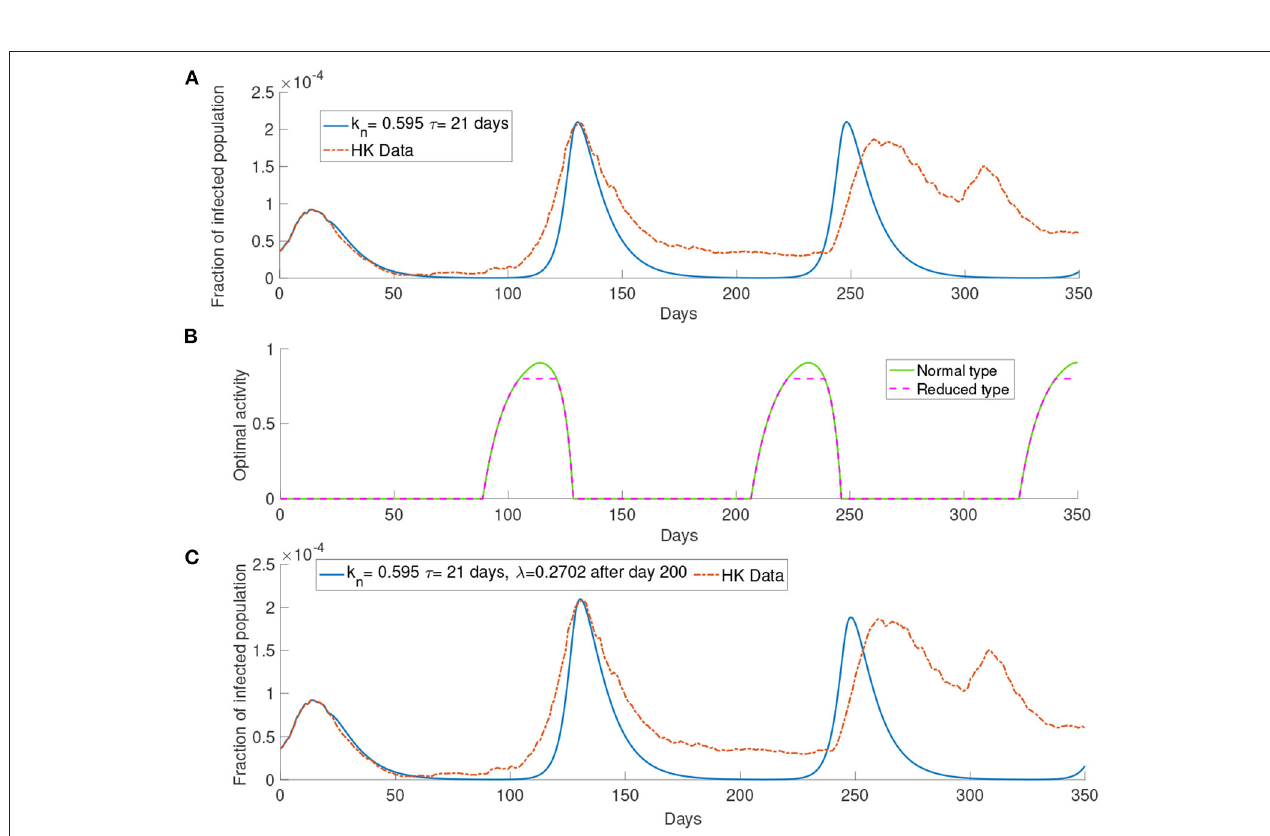
FIGURE 6 | The simulation with the data of Hong Kong. (A) The comparison between the simulated and observed data. (B) The optimal activity. (C) The comparison of the infected population from the data and the simulation of our model with report rate λ increase to 0.2702 after day 200.